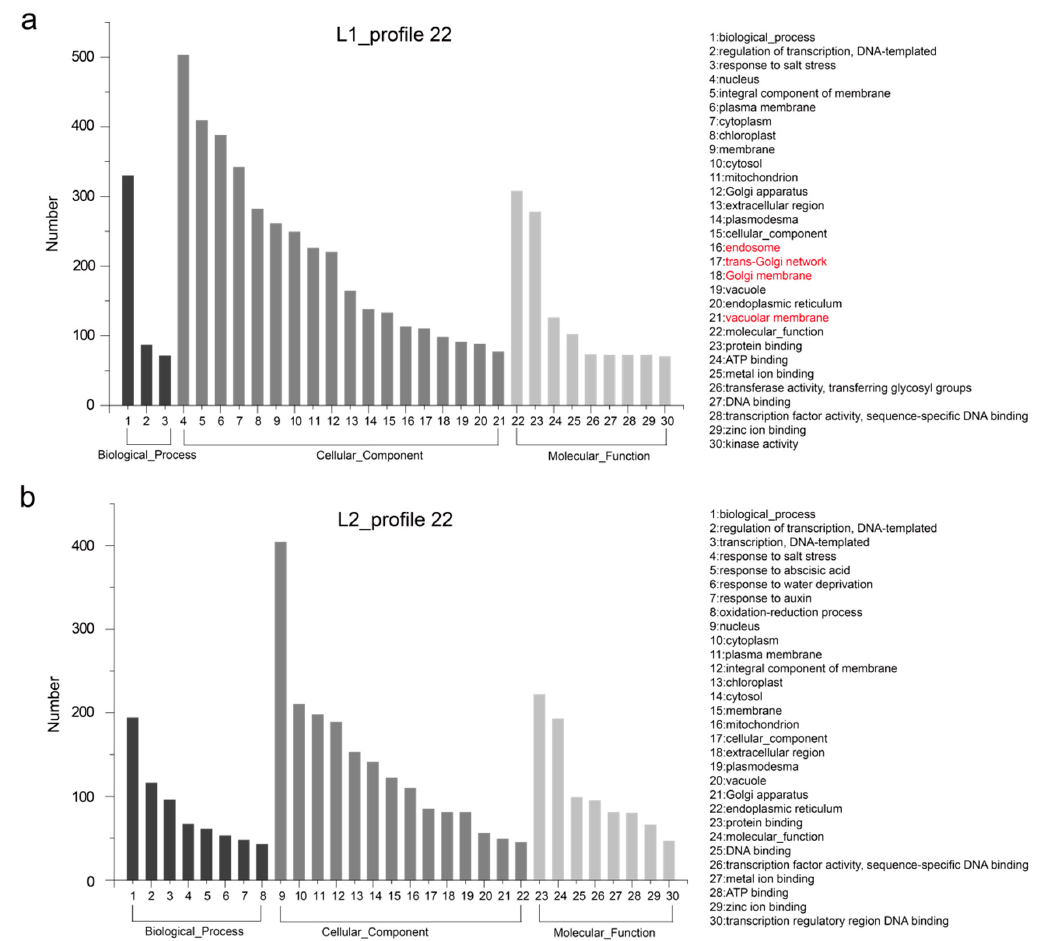
Figure 5. GO enrichment of genes listed in expression profile 22. ( a ) and ( b ) show the top 30 terms of GO enrichment for 1128 and 748 genes unique to L1 and L2, respectively. The main different terms names are highlighted in red.